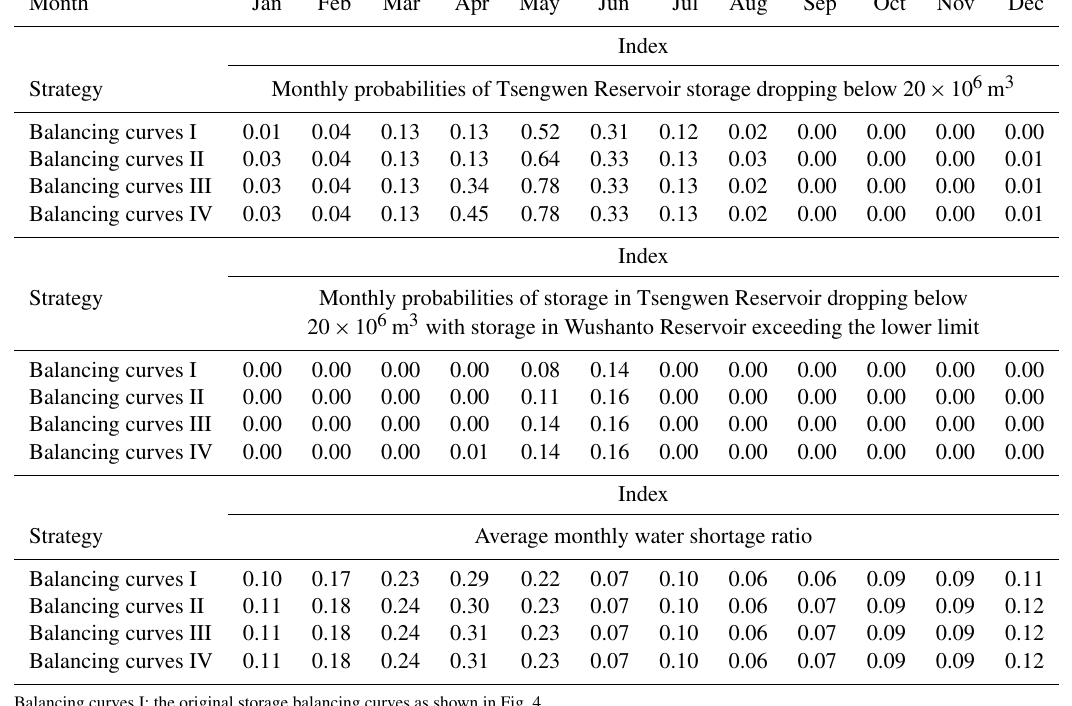
Table 1. Monthly probabilities of Tsengwen Reservoir storage dropping below 20 × 10 6 m 3 under various strategies of storage allocation.